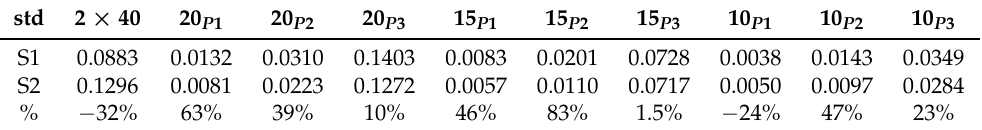
Table 3. The standard deviation indicators (std) calculated for the 1st electrode measurement cycle, where electrodes: 2->32 were grounded. Where 10, 15, 20, 40 stands for object diameter and P1, P2,